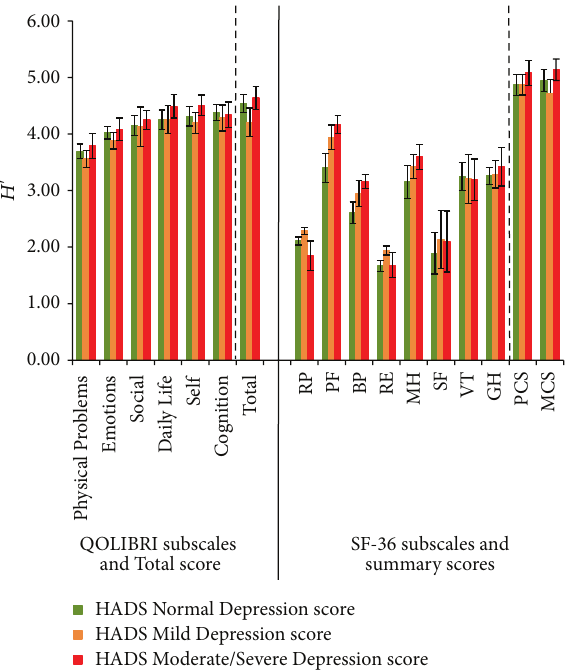
Figure 5: Shannon indices 𝐻 󸀠 (confidence intervals 95%) of all QOLIBRI and SF-36 subscales, QOLIBRI Total score and MCS and PCS for the correlate HADS Depression scores.